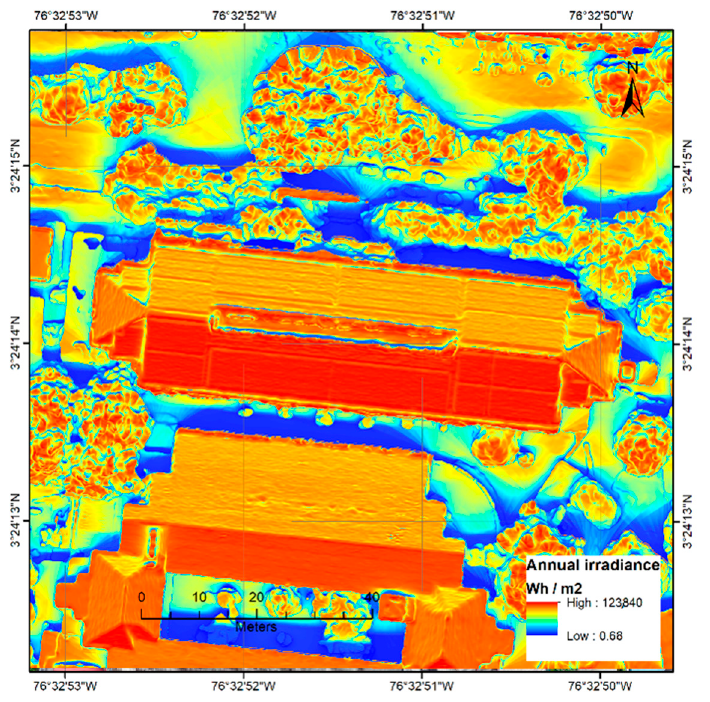
Figure 8. Annual irradiance of the study area in 2019.